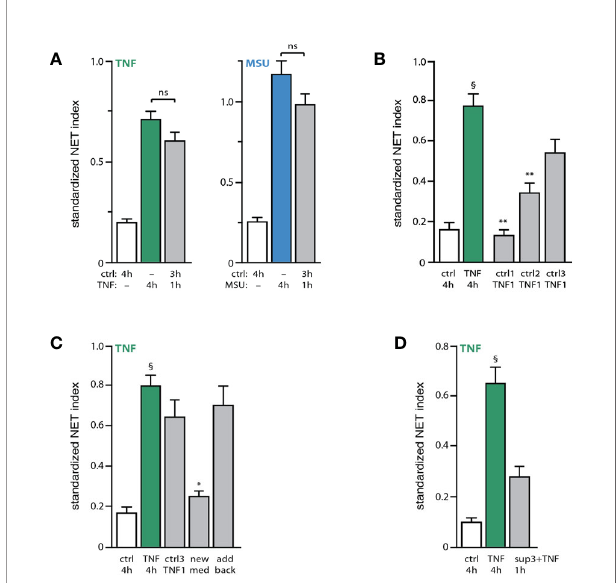
FIGURE 3 | Unstimulated neutrophils condition themselves to quickly form NETs upon stimulation. (A) Neutrophils cultured on poly-L-lysine-coated coverslips were incubated for 4 h in medium alone ( “ ctrl ” ) or with either 100 U/ml TNF a or 1 mg/ml MSU. Alternatively, cells were incubated 3 hours in medium alone and the stimulus was added for another hour. NET formation was assessed using PlaNET Green (TNF) or PlaNET Blue (MSU) as described in Methods . Mean ± s.e.m. from 4 independent experiments. Cell stimulation with TNF or MSU alone yielded signi fi cant (p<0.001) differences versus unstimulated cells. (B) Neutrophils cultured as described above were incubated for 1, 2, or 3 h in medium alone ( “ ctrl1, ctrl2, ctrl3 ” ), prior to a 1-h stimulation with 100 U/ml TNF a ( “ TNF1 ” ). As a control, cells were also incubated for 4 h in the absence ( “ ctrl ” ) or presence of TNF a . NET formation was assessed using PlaNET Green as described in Methods . Mean ± s.e.m. from 3 independent experiments. **p < 0.003 vs TNF 4h; § p < 0.002 vs unstimulated cells. (C) Neutrophils were cultured for 4 h in the absence ( “ ctrl ” ) or presence of 100 U/ml TNF a ( fi rst two bars). Alternatively, cells were incubated 3 h in medium alone, at which point one of three procedures were followed: 100 U/ml TNF a was added and the cells were further incubated for 1 h ( “ ctrl3 TNF1 ” ); or the cultured supernatant was removed and replaced with fresh medium (supplemented with 2% autologous serum) and the cells further incubated for 1 h in the presence of exogenous TNF a ( “ new med ” ); or the cultured supernatant was removed, added back, and the cells were further incubated for 1 h in the presence of exogenous TNF a ( “ add back ” ). NET formation was assessed using PlaNET Green as described in Methods . Mean ± s.e.m. from 3 independent experiments. *p < 0.02 vs TNF 4h; § p < 0.002 vs unstimulated cells. (D) Neutrophils were cultured for 4 h in the absence ( “ ctrl ” ) or presence of 100 U/ml TNF a ( fi rst two bars). Alternatively, cells were incubated for 1 h in the presence of both exogenous TNF a (100 U/ml) and supernatants from unstimulated neutrophils that had been cultured for 3h ( “ sup3+TNF ” ). NET formation was then assessed using PlaNET Green as described in Methods . Mean ± s.e.m. from 3 independent experiments. § p < 0.02 vs unstimulated